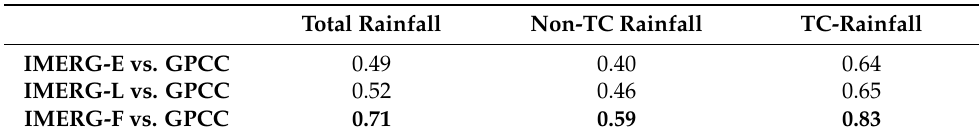
Table 6. Scorr values between GPCC for Figure 9a–c and IMERG products in Figure 2a–c. Highest values are